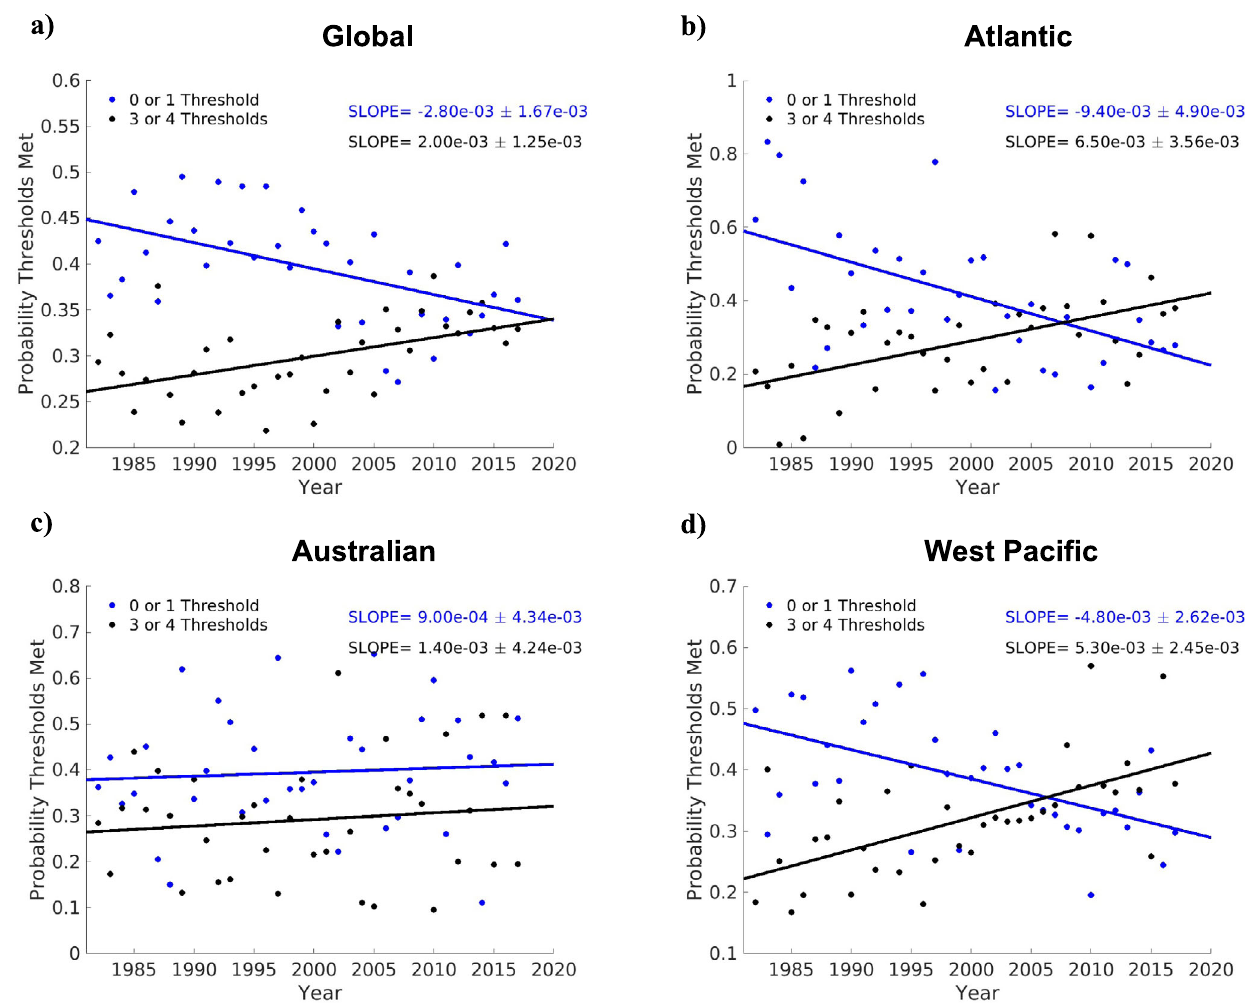
Fig. 4 | Observed trends in the favorability of storm environments. Observed trends in the annual probability of satisfying 3 or 4 (black)and 0 or 1 (blue) critical ERA5environmentalthresholdsoverthe36-yearperiod1982 – 2017using( a )Global and ( b ) Atlantic ( c ) Australian ( d ) West Paci fi c data. Annual values are denoted by